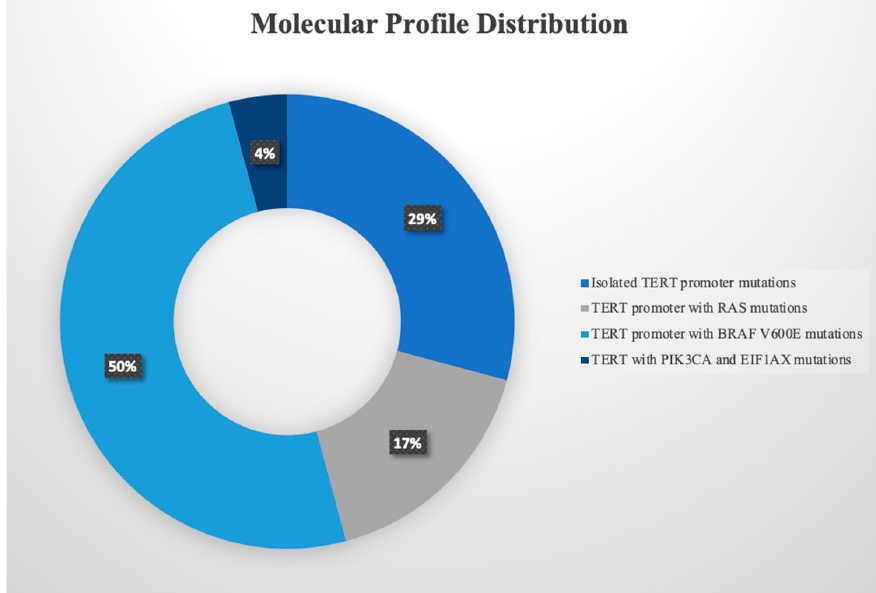
Figure 1. Mutation profile distribution of patients who underwent ultrasound-guided fine needle aspiration of a dominant thyroid nodule and tested positive for a TERT promoter mutation using ThyGeNEXT ® or Thyroseq V3 ® .